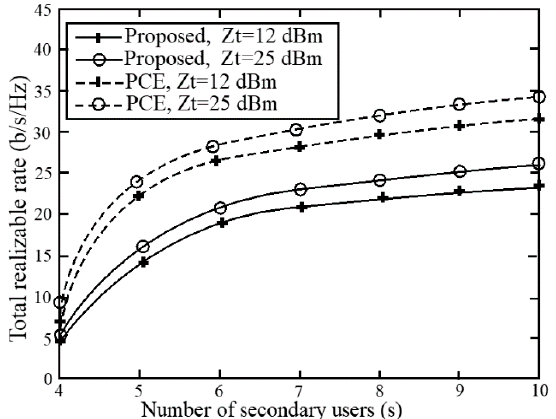
Figure 2. The total realizable rate of the secondary network via the total number of secondary users (SUs) with different values of total power Z t and scenarios.